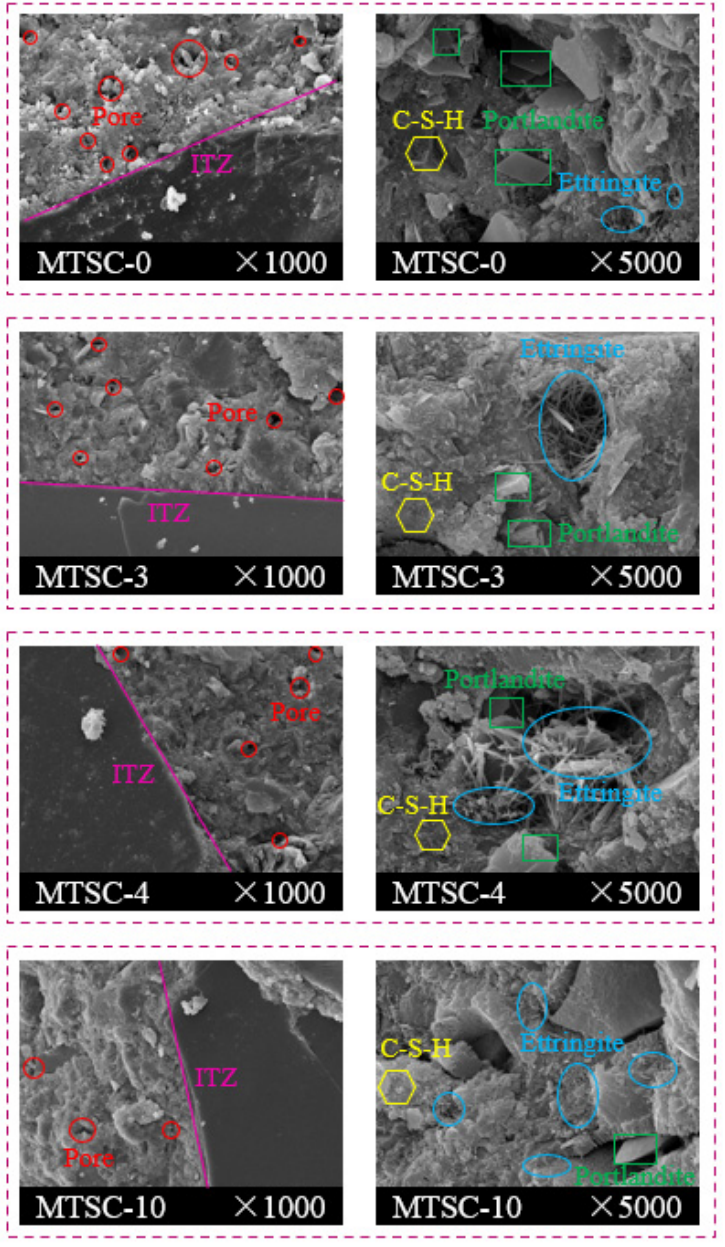
Figure 11. The SEM images of MTSC-0, MTSC-3, MTSC-4 and